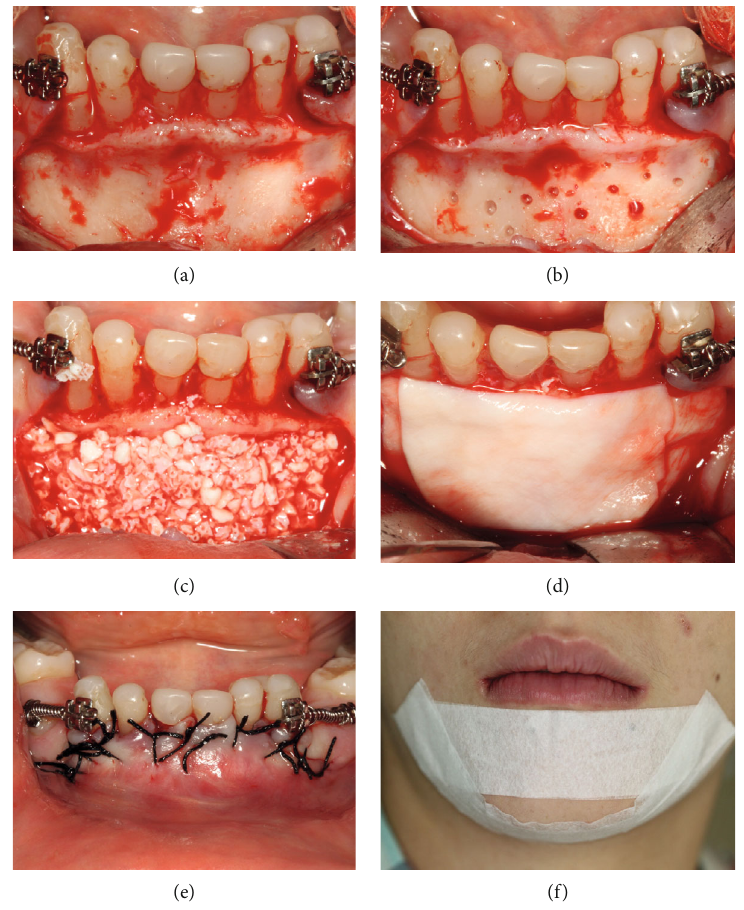
Figure 3: Intraoral view of the surgery steps: (a) incision and total fl ap detachment, (b) cortical perforations, (c) bone substitute accommodation, (d) double layer collagen membrane, (e) single sutures, and (f) bandage